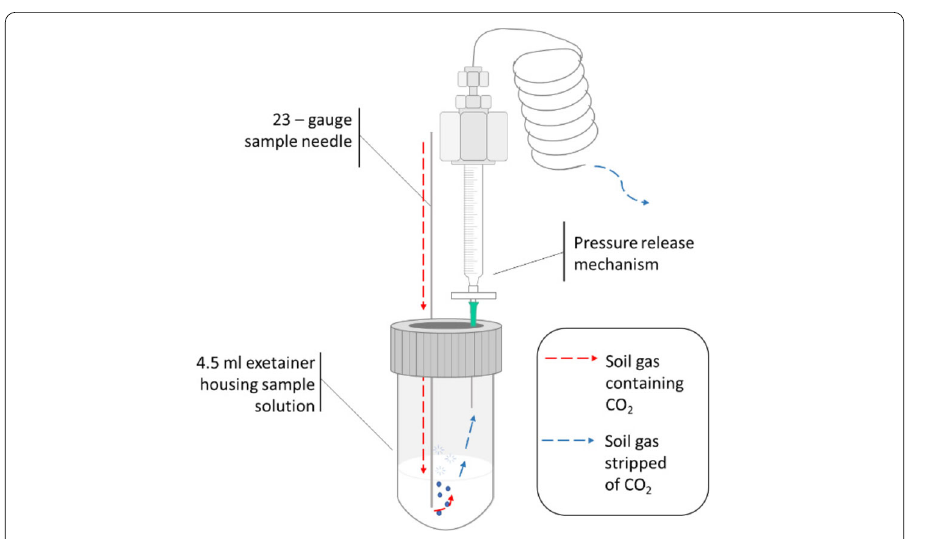
Figure 5 Filter cartridge assembly with Ba(OH)2 for collection CO 2 from soil gas. Schematic by L. (Reynolds) Shaw